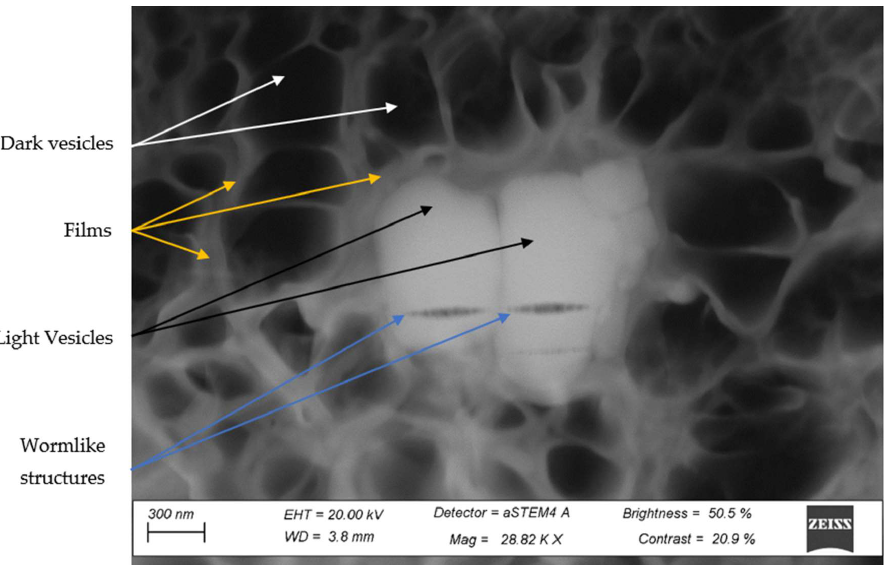
Figure A2. STEM image 2 with HAADF mapping of third phase. Vesicles: bright and dark amorphous areas with distinct boundaries indicated by black and white arrows, respectively; films: filamentous grey regions surrounding vesicles indicated by yellow arrows; wormlike structures: black linear regions within the light vesicles indicated by blue arrows.